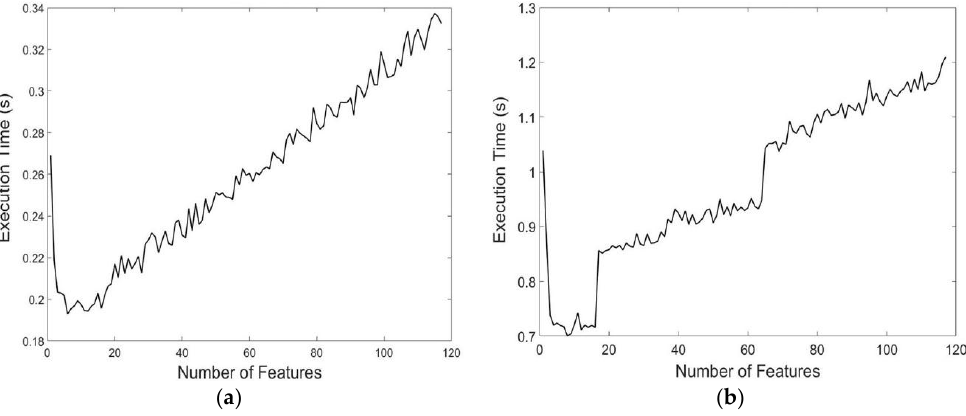
Figure 11. Execution time evolution with increasing number of features for the Sentinel-2 based RF crop type classification, showing in ( a ) the training time evolution and ( b ) the implementation time evolution.